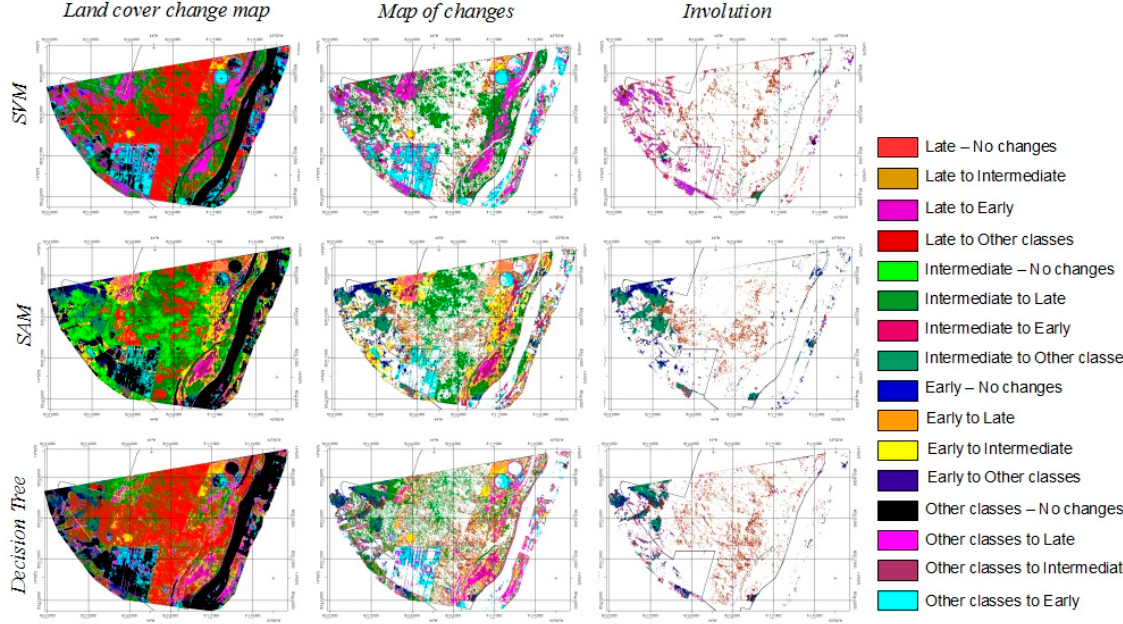
Figure 5. Land cover changes in PEMS, between 2008 and 2014 according to different classifiers.